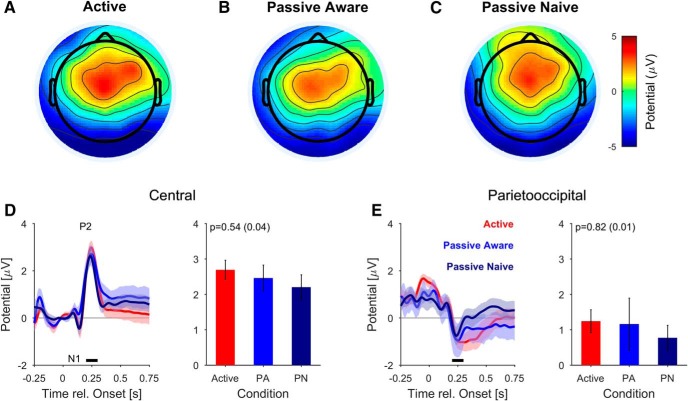
Onset responses are similar across levels of task engagement. A–C, The scalp distribution of the P2 component (200 ms after stimulus onset) is centered with a slight asymmetry toward the front. Since the different stimulus conditions are all matched at the onset, the data were averaged over all stimuli. The scalp topography in the passive–aware conditions mirrors the active potential (B). In the passive-naive conditions, the topography was still centered, but slightly broadened toward frontal locations, probably due to uncontrolled blinks (C). Overall, the topographies were not statistically different (see text for details). Subject involvement was supported by their relative level of α-band activity (Extended Data Fig. 3-2). D, The central potential, typically associated with auditory-cortex activity (Nie et al., 2014), exhibited a classical response sequence after stimulus onset, with a negative component (N1, 150 ms) followed by a positive component (P2, 242 ms), both slightly delayed compared to classical latencies for pure tones (left, average over electrodes Cz, C1 and C2). The P2 peak size decays slightly but nonsignificantly from active to passive-aware and passive-naive (right, height averaged in [0.2-0.3]s). E, The onset-elicited response in the PO region also displayed a negative deviation around [0.2,0.3]s (left, electrodes Pz, POz), which likely reflects the negative part of the auditory cortex dipole (Extended Data Fig. 3-1) This activity did not differ significantly across conditions. Error bars in all plots indicate ±1 SEM. Effect size is given in parentheses after the p value.